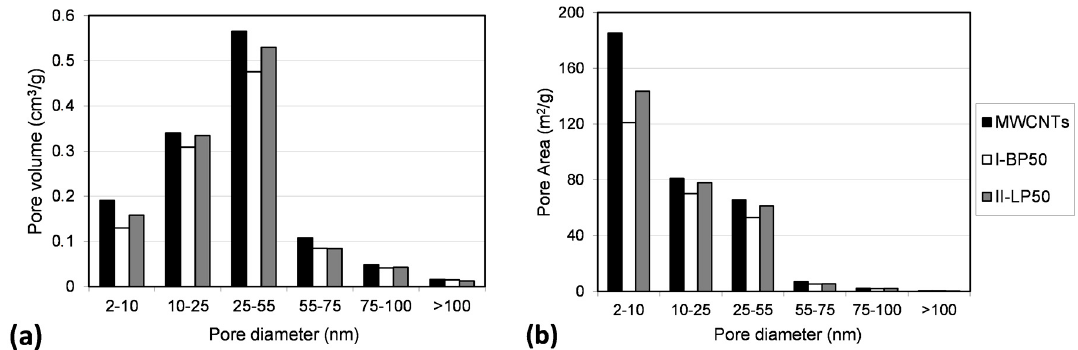
Figure 3. Pore volumes ( a ) and pore areas ( b ) of samples before (MW ‐ CNTs) and after PFPE ‐ functionalization with branched ( I ‐ BP50 ) and linear ( II ‐ LP50 ) peroxides.